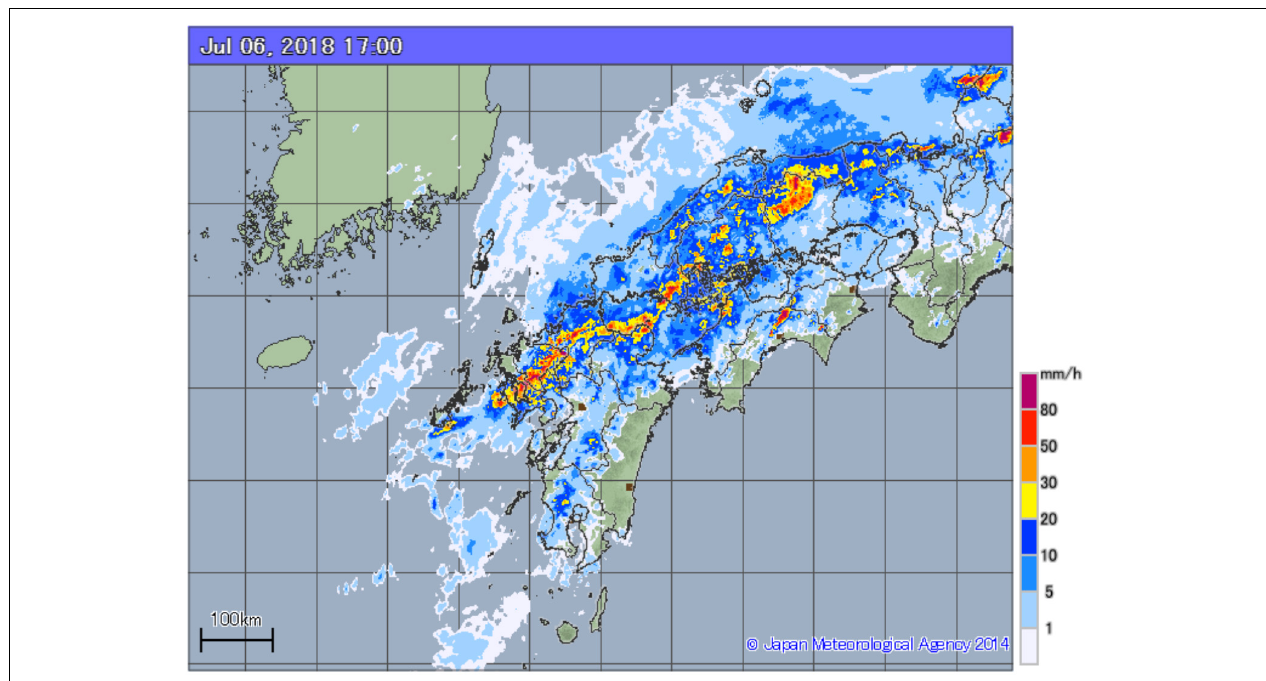
FIGURE 1 | High-resolution map of the rainfall rate at 17:00 JST (08:00 UT) July 6, 2018, from JMA (https://www.data.jma.go.jp/fcd/yoho/meshjirei/jirei01/high resorad/index.html).